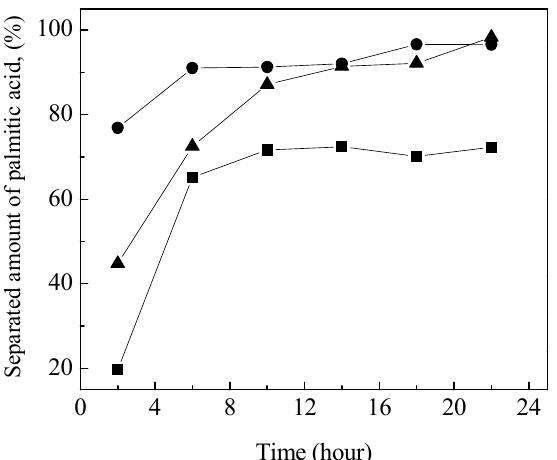
Figure 6. Separated palmitic acid as a function of cooling time and temperature: ( ■ ) 15 °C, ( ● ) 18 °C, ( ▲ ) 21 °C.